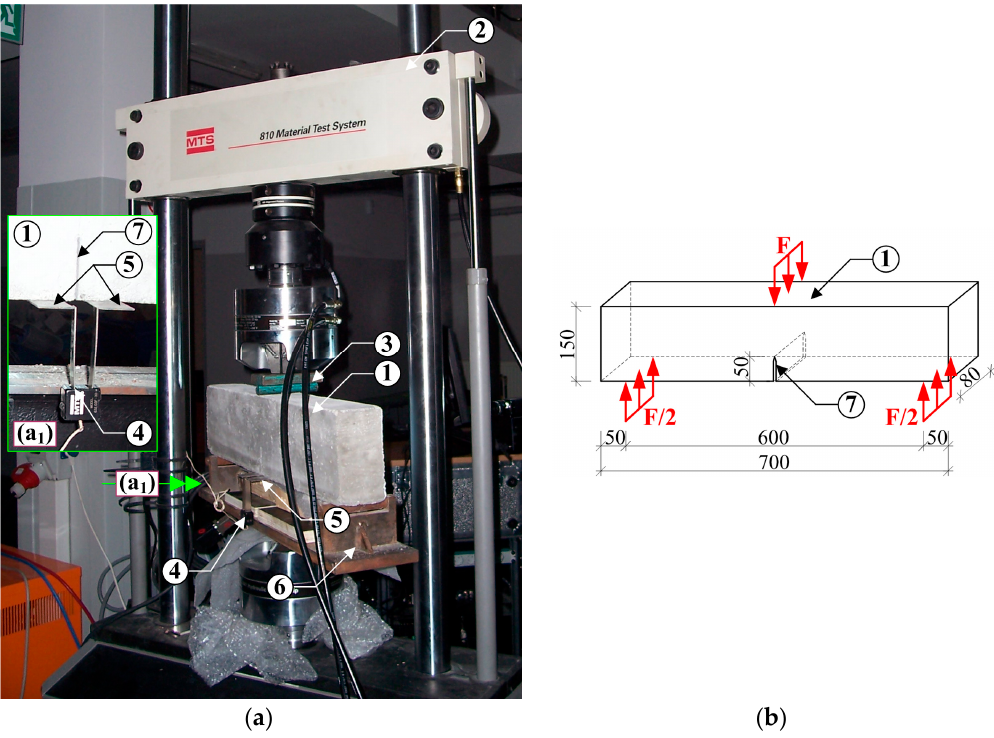
Figure 5. View of experimental stand for testing according to mode I fracture: ( a ) specimen during testing with the detail (a 1 ) the position of the extensometer in the grips; ( b ) specimen with dimensions and loading conditions; 1—specimen, 2—MTS 810 press, 3—system applying force onto the specimen, 4—axial clip gage extensometer, 5—clamping test grips, 6—supporting system, 7—initial crack (dimensions in mm).